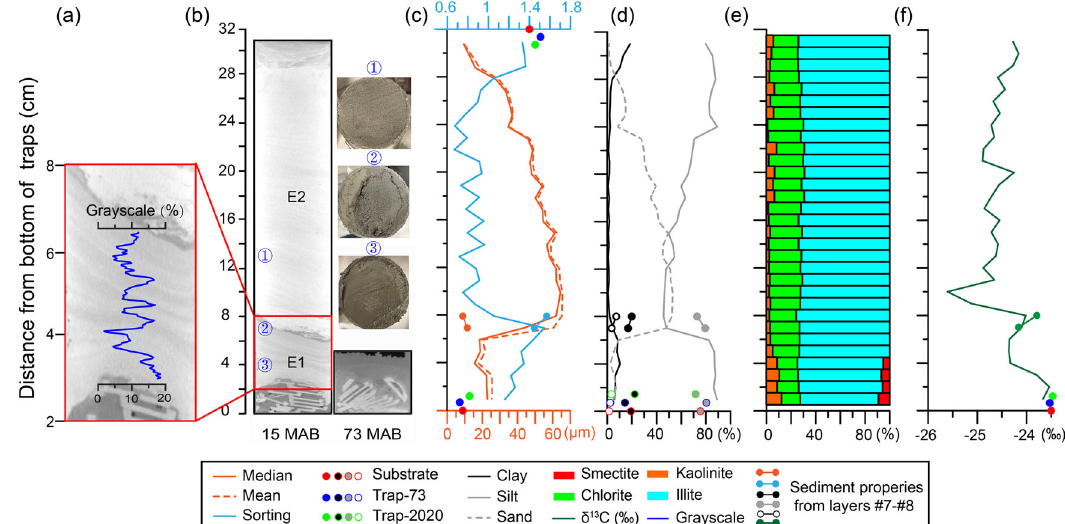
Fig. 5 Properties of sediments collected from the 2020 deployment, the 2021 deployment and the substrate at the mooring site S2. a The gray-scale values of 3 – 7 cm of the sediment at 15 MAB are indicated by the blue line. b The gray scale maps are computed-tomography (CT) images of sediment trapped from E1 to E2. The coarser the grain size, the lighter is the color of the CT images. The blue circled numbers denote the positions of cross-section photos. c Median and mean grain size and sorting of the collected sediment. d The content of clay, silt and sand, ( e ) proportion of the clay minerals, and ( f ) the content of δ 13 C relative to PDB. In the legends, sediment properties from layers #7-#8 ’ denotes the fi ner sediment samples of layers #7-#8 (hereafter ‘ _F ’ ). Layers #7-#8 ’ located in the oblique interface between the deposits from the turbidity currents E1 and E2, containing the sediment from E1 to E2. The ‘ Substrate ’ in legends indicates the substrate sediment sampled in 2020 at the site X02 (see the location in Fig. 1b). The ‘ Trap-2020 ’ and ‘ Trap-73 ’